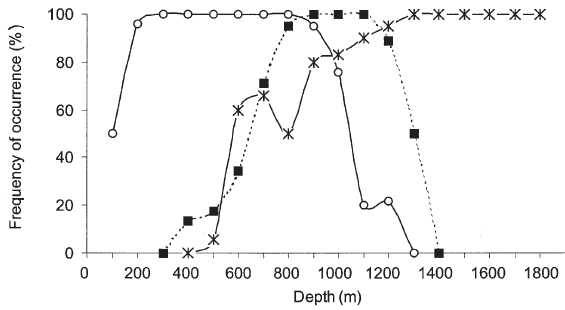
F IG . 2. – Bathymetric distribution of frequency of appearance for Phycis blennoides (empty circles) Mora moro (full squares) and Lepidion lepidion (asterisks)